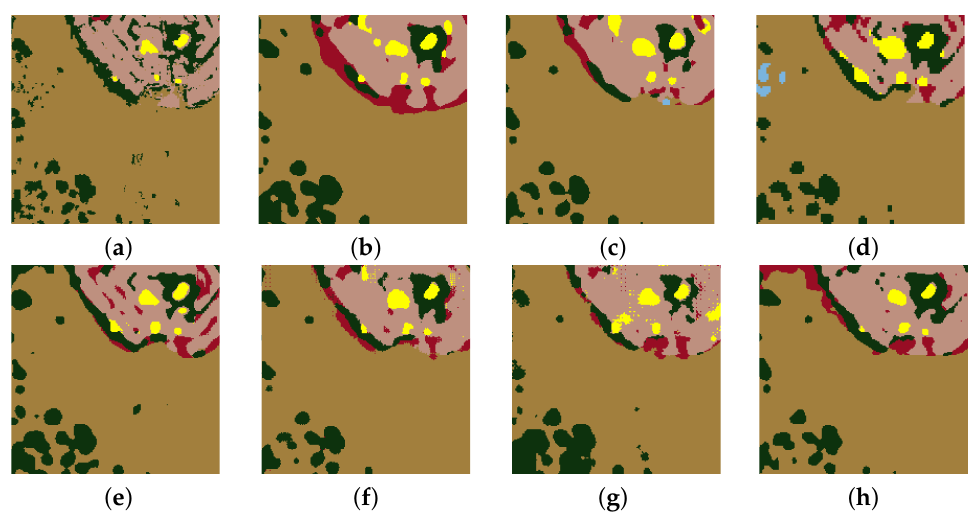
Figure 13. Segmentation results from different models using the test subset. ( a ) GT image, ( b ) U-Net, ( c ) DeepLabV3 + , ( d ) HRNet, ( e ) U-Net with SR inputs, ( f ) Dual_DeepLab, ( g ) Dual_DeepLab_RRDB, ( h ) SEG-ESRGAN. Image size: 200 × 200 pixels.